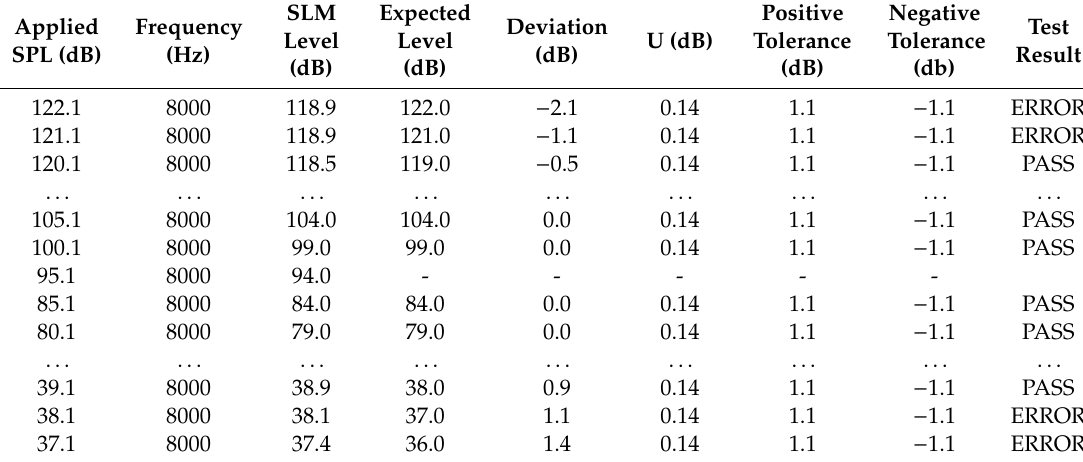
Table 3. The results obtained for the linearity test. Values marked with “ ... ” are omitted for clarity (the device passed the test). SLM = sound level meter.